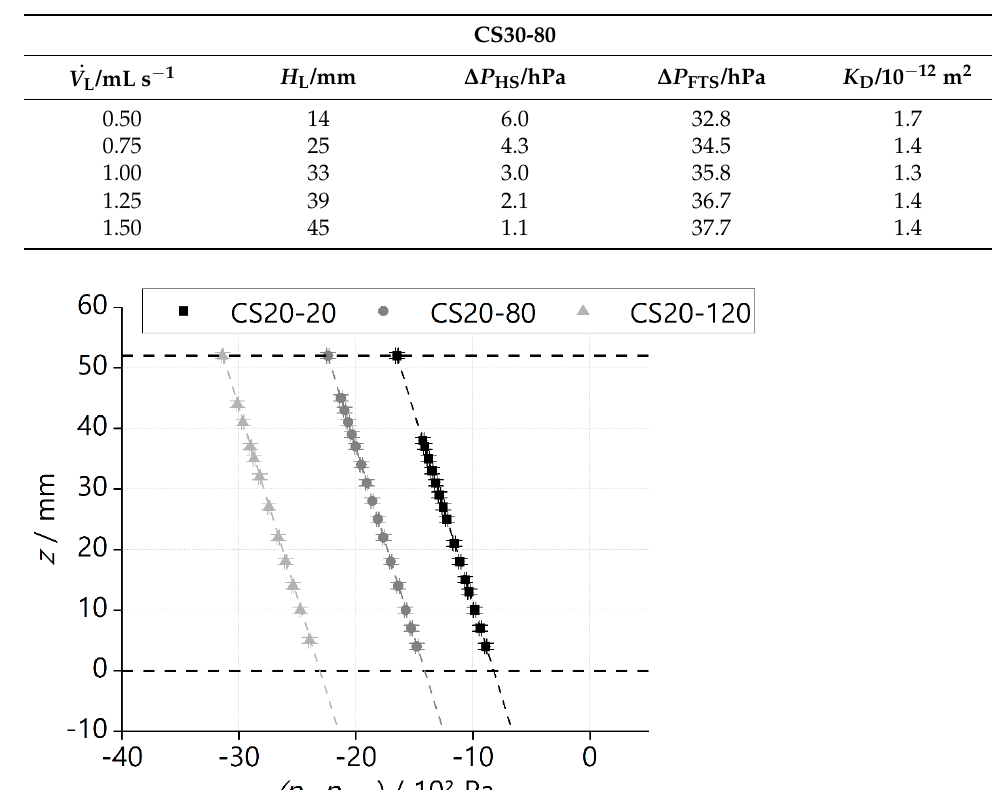
Table 8. Phase-separation experiment parameters and results for sample CS30-80 with ∆ P BP = 38.8 hPa, . h EH = 245 mm and ( V L ) = 1.79 mL s − 1 . max